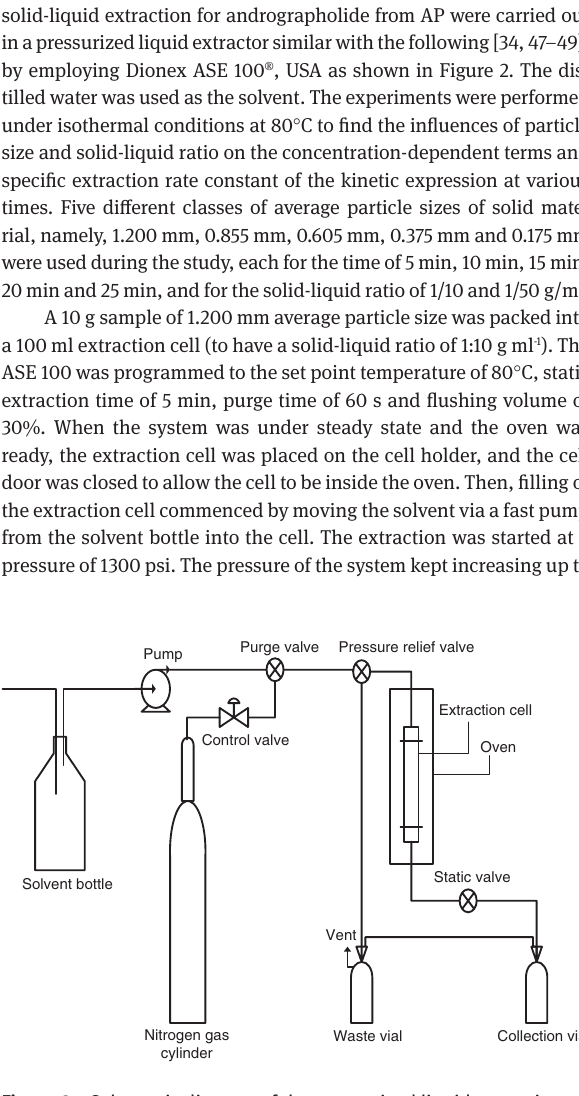
Figure 2: Schematic diagram of the pressurized liquid extraction (PLE) system.